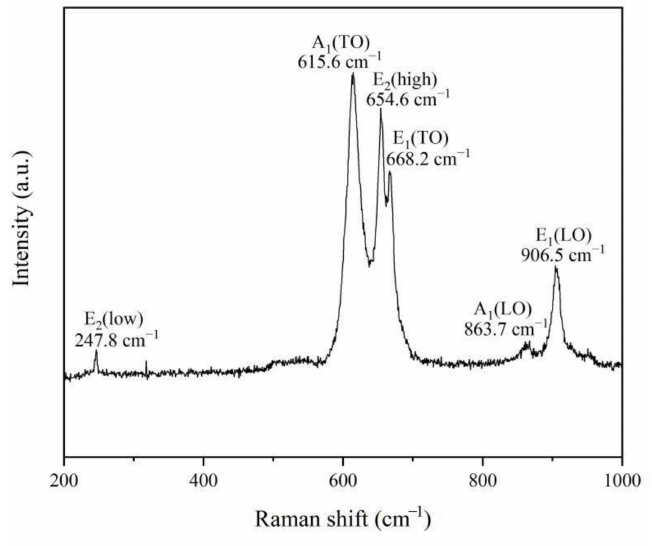
Figure 6. Room-temperature Raman scattering spectrum of AlN nanowires.